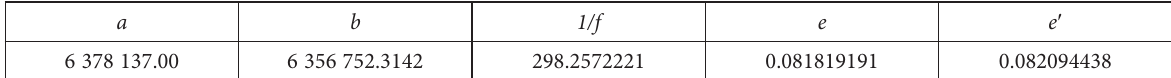
Table 5. Parameters of the WGS84